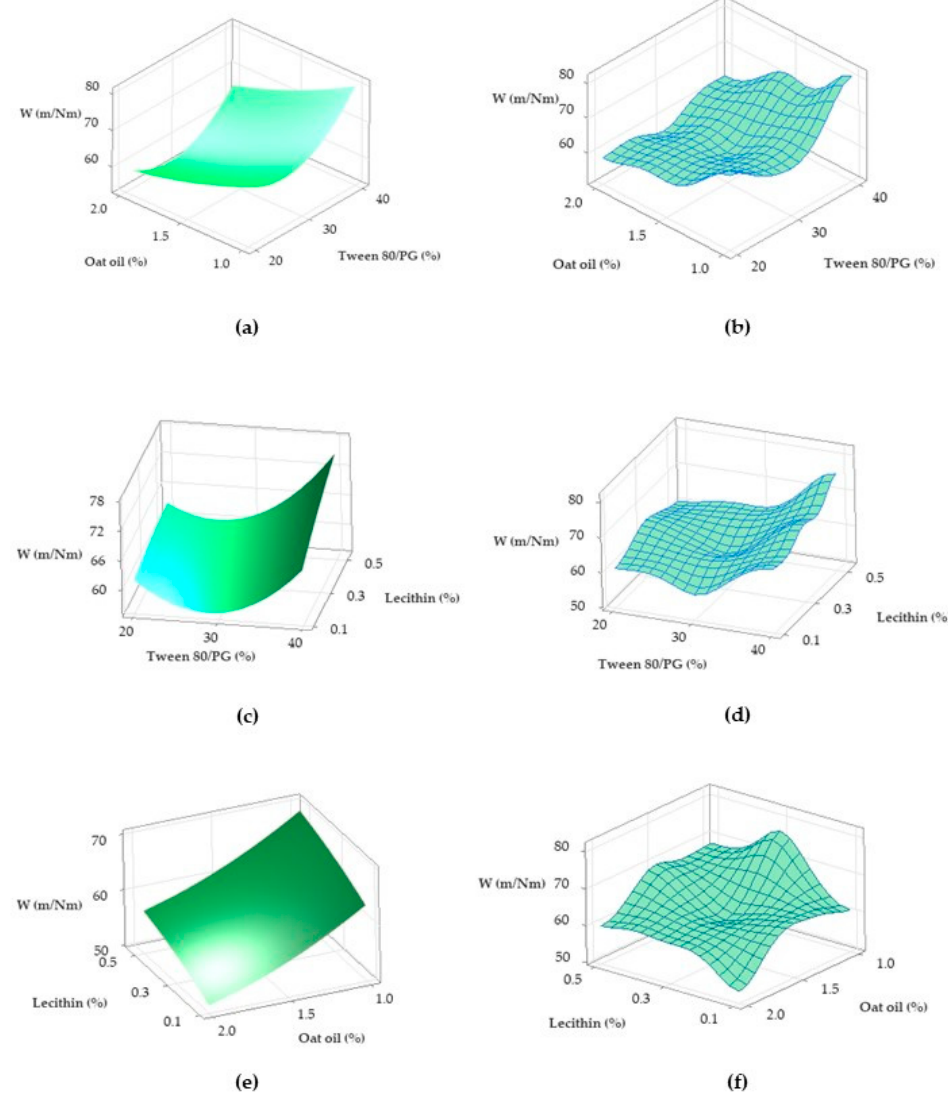
Figure 23. Surface plots representing: W response (Y 3 ) as a function of Tween 80/PG (%) and Oat oil (%), in two cases—( a ) Surface representation in gradient color, ( b ) Wireframe model; W response (Y 3 ) as function of Tween 80/PG (%) and Lecithin (%), in two cases—( c ) Surface representation in gradient color, ( d ) Wireframe model; W response (Y 3 ) as function of Oat oil (%) and Lecithin (%) in two cases—( e ) Surface representation in gradient color, and ( f ) Wireframe model.